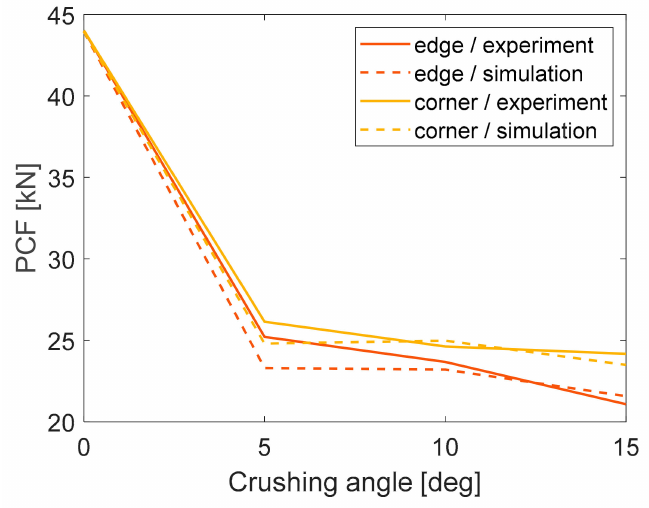
Figure 18. PCF variation with crushing angle.